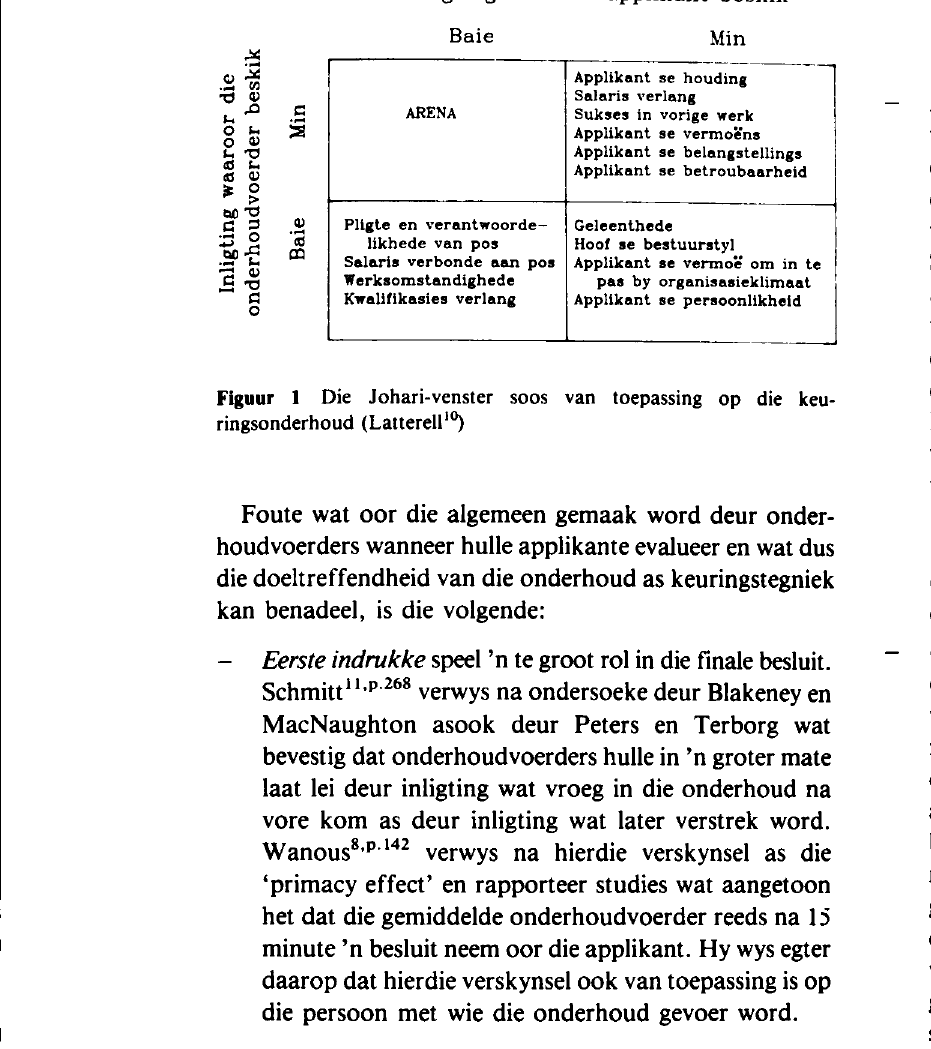
Figuur 1 Die Johari-venster soos van toepassing op die keu ringsonderhoud (Latterell 1